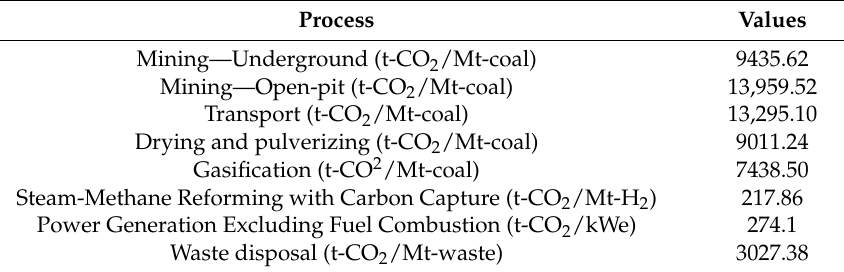
Table 9. Life cycle inventories (LCIs) for upstream